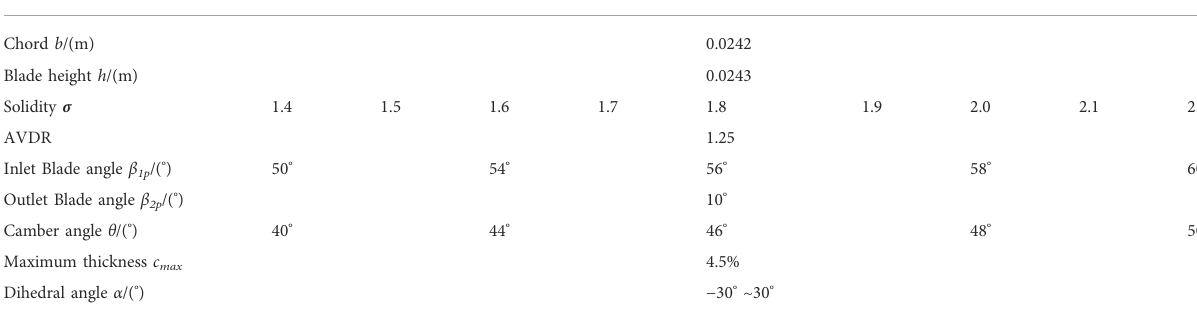
TABLE 1 Parameters and fl ow conditions of